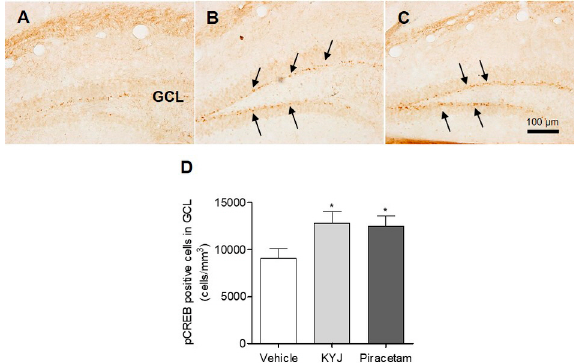
Figure 4. KYJ stimulated the phosphorylation of hippocampal CREB in mice. ( A – C ) Representative images of each group are shown: ( A ) vehicle-treated group, ( B ) KYJ 200 mg / kg / day (per os; p.o.) group, ( C ) piracetam 200 mg / kg / day (Intraperitoneal injection; i.p.) group. ( D ) The number of pCREB-positive cells (black arrow) in the GCL region was quantified via stereological counting. * p < 0.05 vs. the vehicle-treated group.